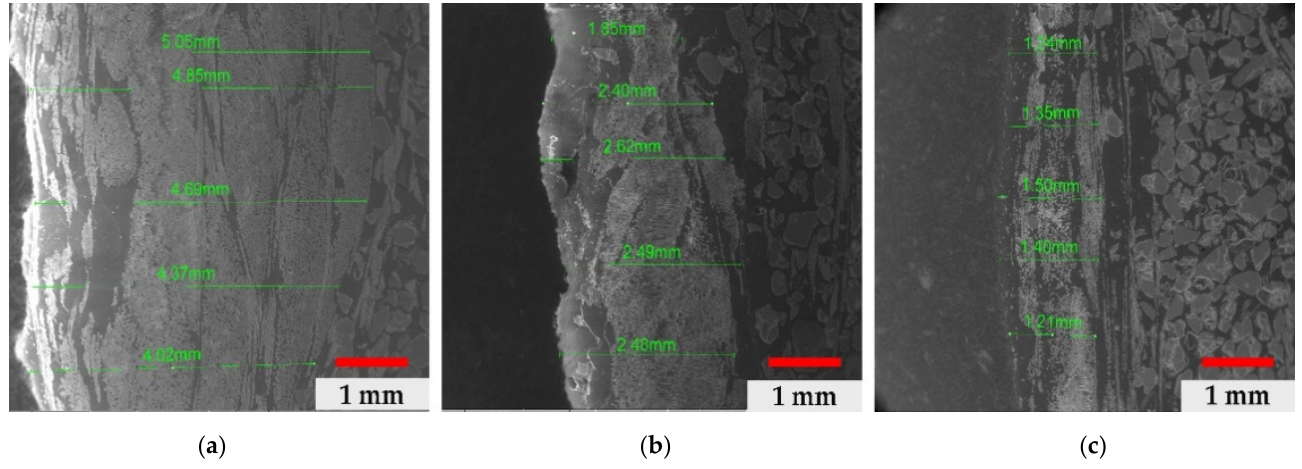
Figure 5. Dimensional variation in the outer layer: ( a ) neutral soil, ( b ) basic soil, ( c ) acidic soil. Structural analysis of external areas—as shown in Figure 6a–c—highlights fibrous structures with different orientations with the same calcium aluminosilicate morphology.